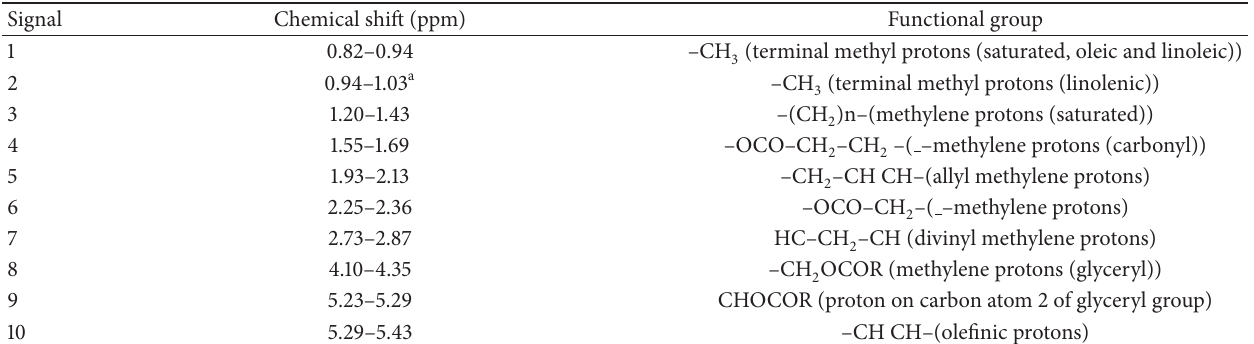
Table 1: 1 H-NMR spectral peak assignment ∗